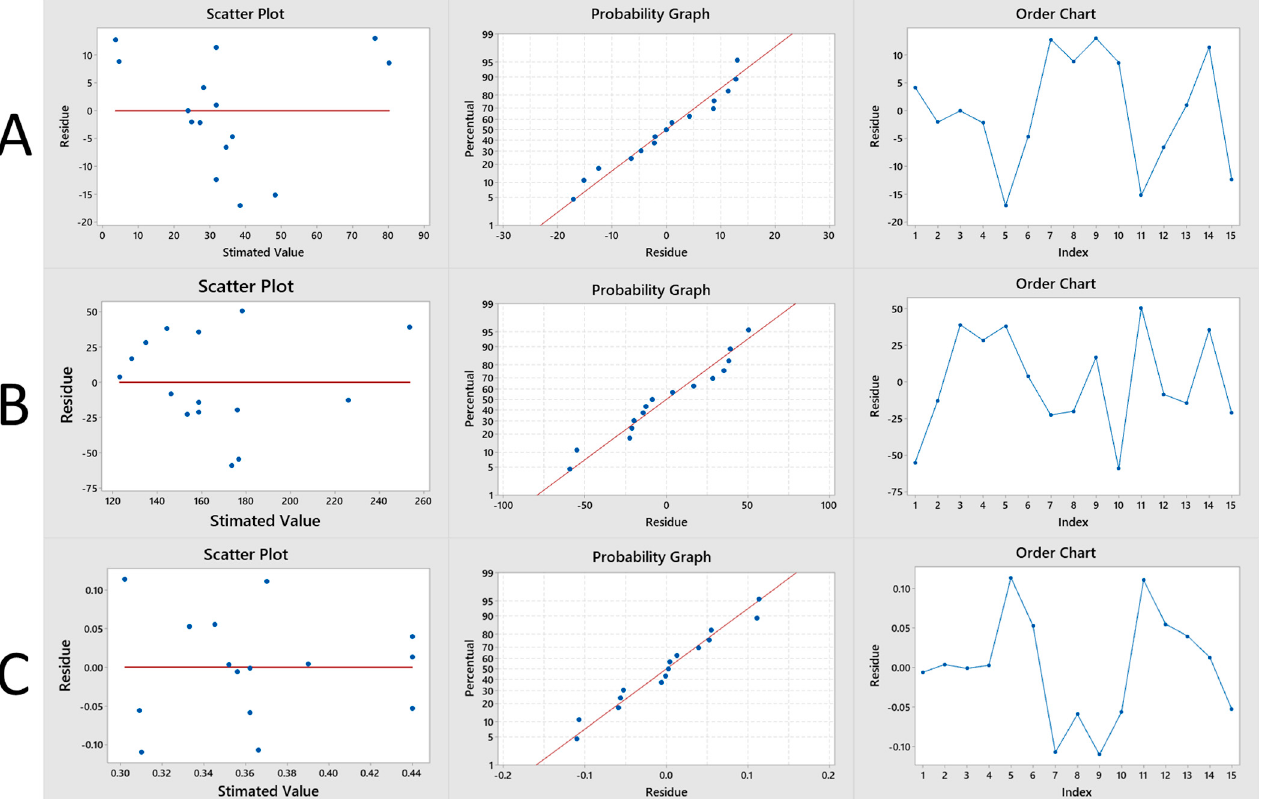
Figure 3. Graphs of normal probability (percentage vs. residual), of residuals versus adjusted values and observation order versus residual in relation to variables Y 1 , Y 2 and Y 3 . The graphs were combined and aligned in the figure in relation to each response analyzed in the experimental design, in which the line graphs ( A ) relate to the encapsulation efficiency (Y 1 ), in ( B ) to the particle size (Y 2 ) and in ( C ) the polydispersity index (Y 3